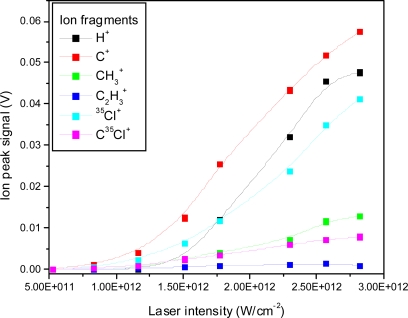
Ion peak signals as a function of laser intensity for H+, C+, CH3+, C2H3+, 35Cl+, C35Cl+ fragment ions using 532 nm laser radiation with 8 ns pulse duration.